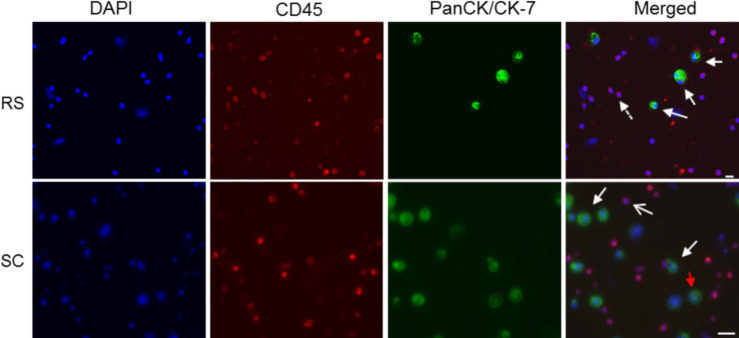
Representative images of controls using spiked MDA-MB-231 cells into whole blood after CTC enrichment and immunocytochemistry.Top panel: Cytospin preparations from CTC enrichment using the RosetteSep™ method. One hundred MDA-MD-231 cells were spiked into 5 mL of whole blood. Positive cells for cytokeratins are coloured green (white arrow), leukocyte positive for CD45 are coloured red (dashed arrow) and the nuclei stained by DAPI are shown in blue. Images were captured under 200X magnification. Bottom panel: CTC enrichment by ScreenCell® Cyto filters. One hundred cultured cells were spiked into 3 mL of whole blood. Cells that are CD45-, pan-CK/CK-7+ and with an intact nucleus are considered positive. Filter pores are visually distinct and a CTC caught atop a filter pore is indicated by the red arrow. A leukocyte caught in the filter pore is shown with an opened white arrow. Images were captured under 400X magnification. Scale bar represents 20 μm. RS: RosetteSep™; SC: ScreenCell®.